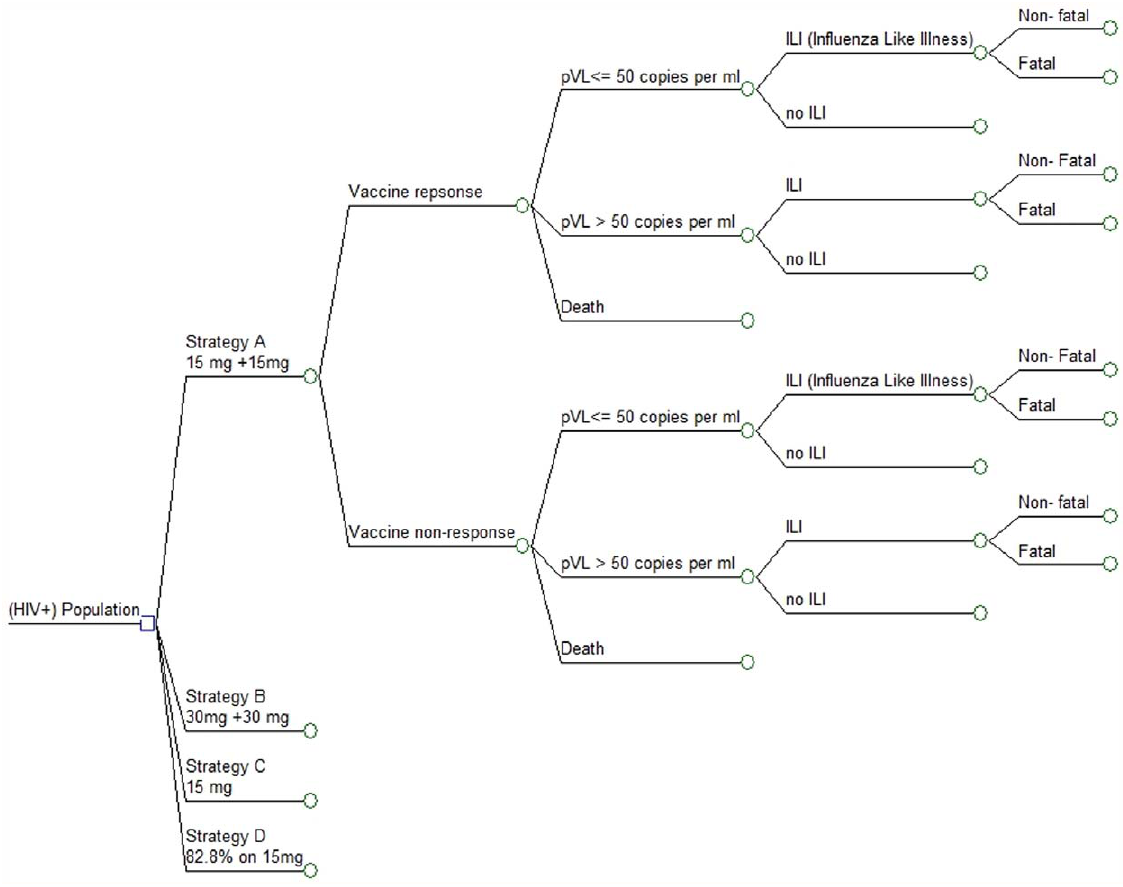
Figure 1. Decision analytic model. All nodes following vaccine response are repeated each month throughout the initial 12 months of the model duration; therefore patients not suffering fatal ILI or death due to other causes may transition from HIV viral load suppression to non-suppression, and subsequently face differential risk of ILI at each month. The probability of ILI is summed across each of the three strains of influenza assessed in CTN-237.